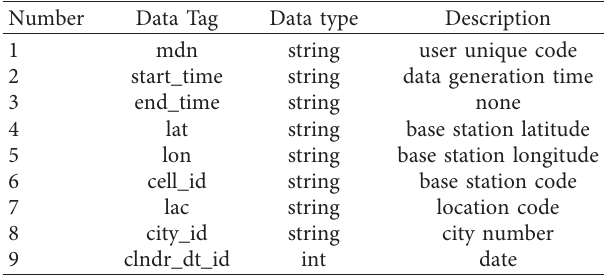
Table 1: Data tags of mobile phone 4G signaling